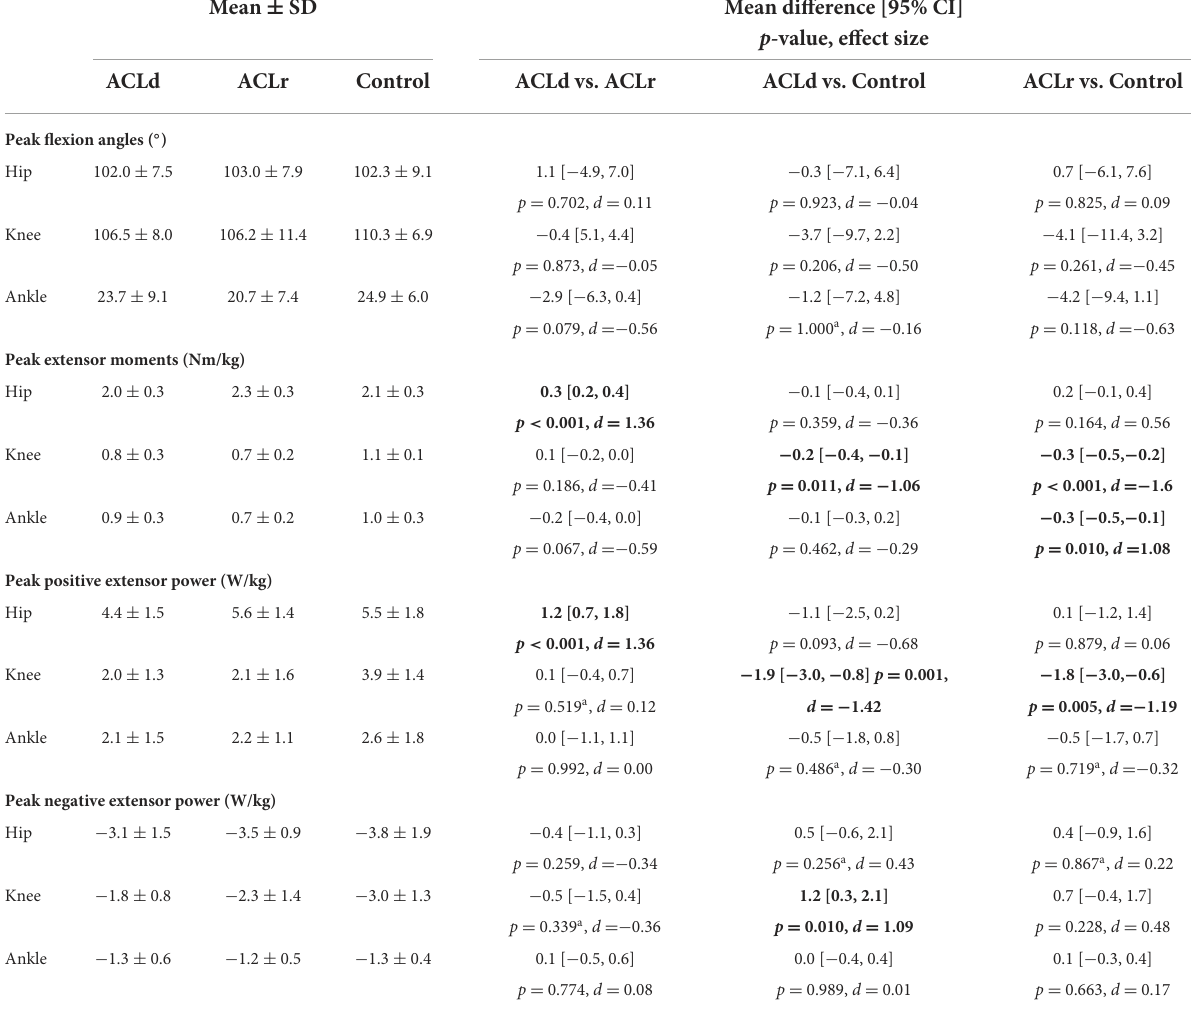
TABLE 2 Peak values of hip, knee and ankle kinematics and kinetics during the forward lunge in patients with an ACL injury and healthy controls. Mean ± SD Mean difference [95% CI] p -value, effect size ACLd vs.